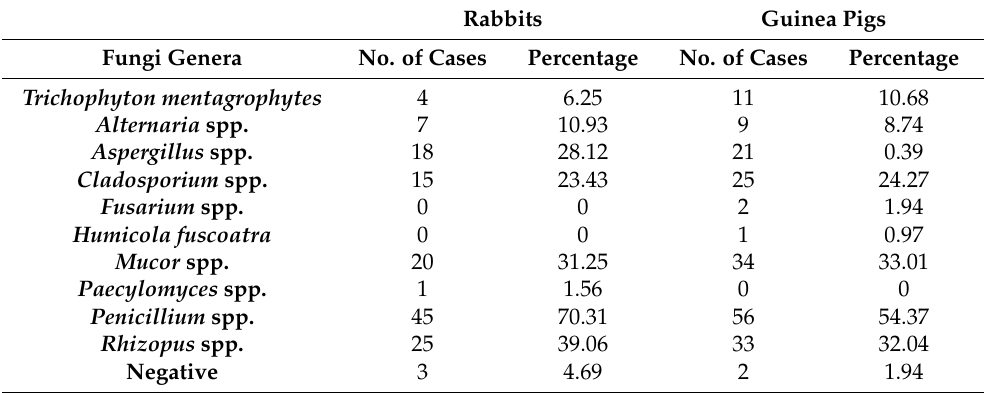
Table 2. Genera of fungi isolated from the skin and hair of 64 rabbits and 103 guinea pigs.